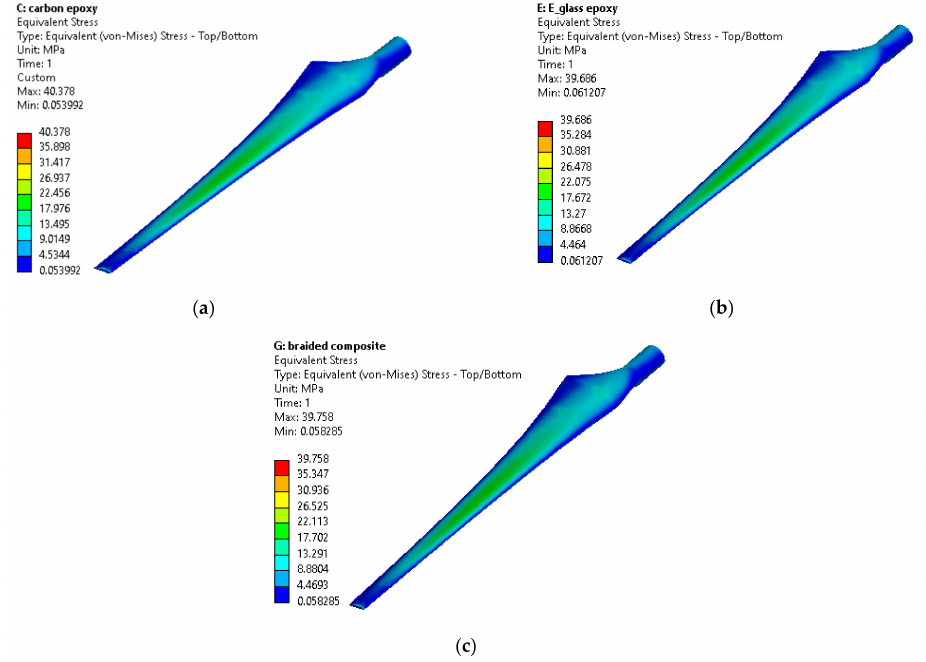
Figure 10. Distribution of Von Mises stresses of ( a ) carbon/epoxy, ( b ) E-glass/epoxy, and ( c ) Braided